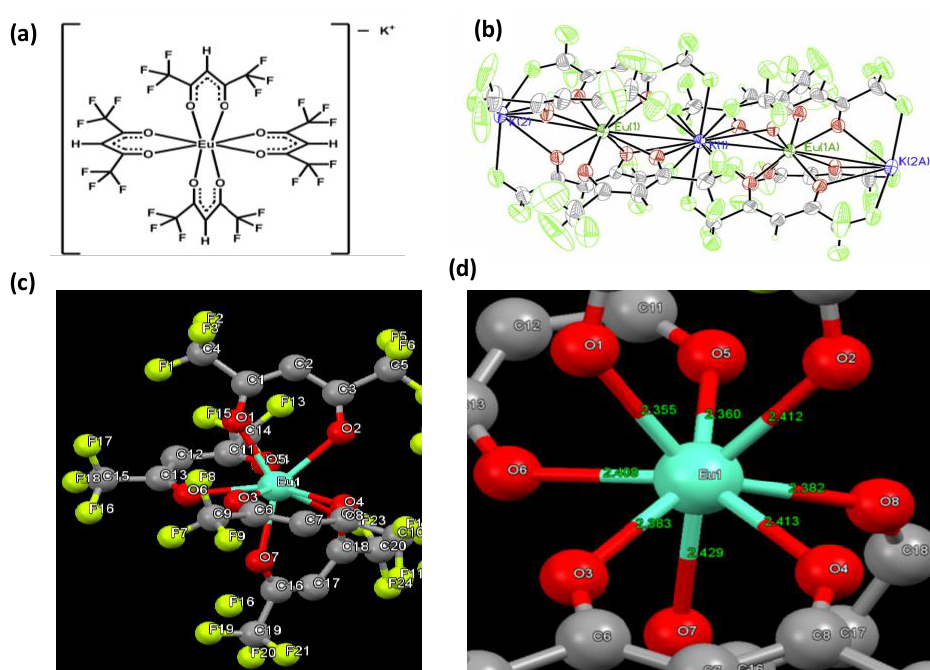
Figure 1. ( a ) Molecular structure of K[Eu(hfa) 4 ] and three views of its crystal structure, showing: ( b ) 50% thermal ellipsoids of two adjacent repeat units of the entire structure; ( c ) ball and stick drawings of a single complex anion unit (hydrogen atoms removed for clarity); and ( d ) a zoomed view thereof showing the coordination sphere with Eu-O distances labeled in Å units.